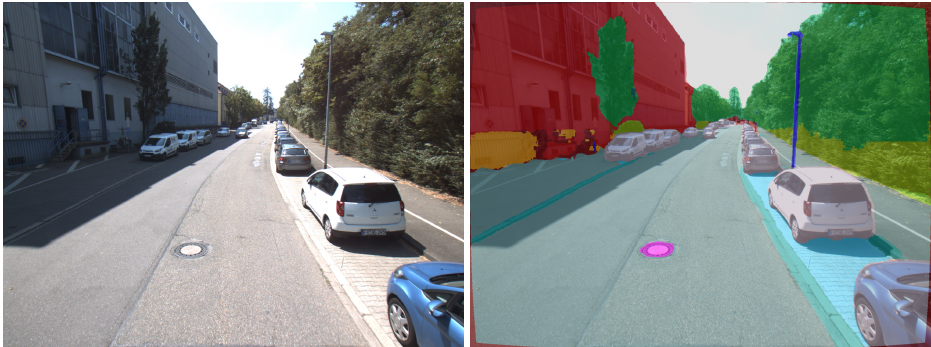
Figure 10. Original RGB image ( left ). Semantic segmentation produced by DL approach ( right ).